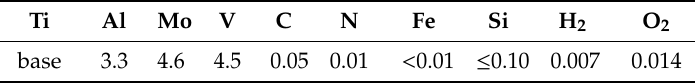
Table 1. Chemical composition of Ti-Al-Mo-V alloy (wt %).